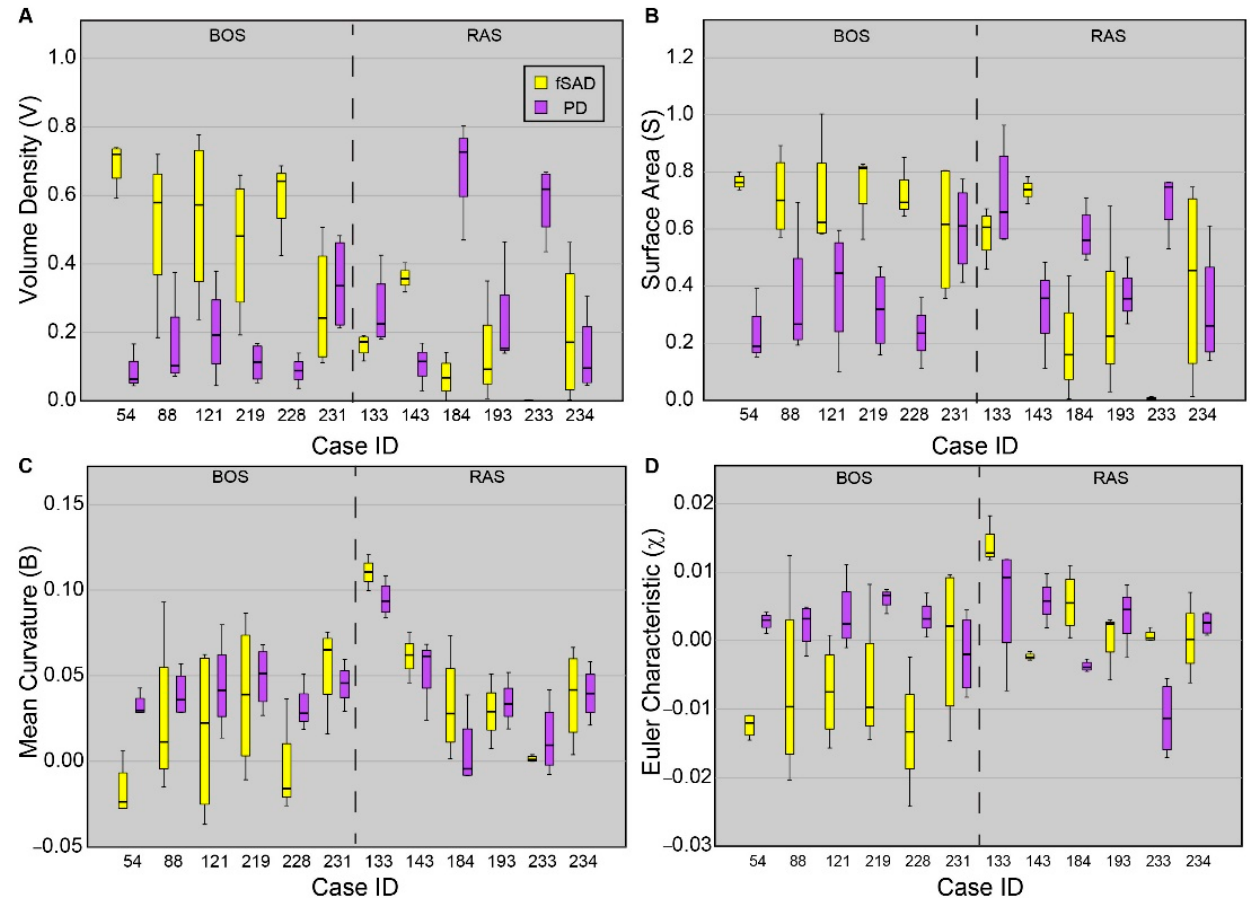
Figure 4. Boxplots for all four tPRM metrics of the dominant readouts from each patient. Presented is the ( A ) volume density, ( B ) surface area, ( C ) mean breadth, and ( D ) Euler–Poincaré characteristic, for fSAD (yellow) and PD (purple). Approximately four cores were acquired from each patient. Box lines represent the lower quartile, median, and upper quartile, and whiskers represent minimum and maximum values. Cases were separated based on disease subtype.